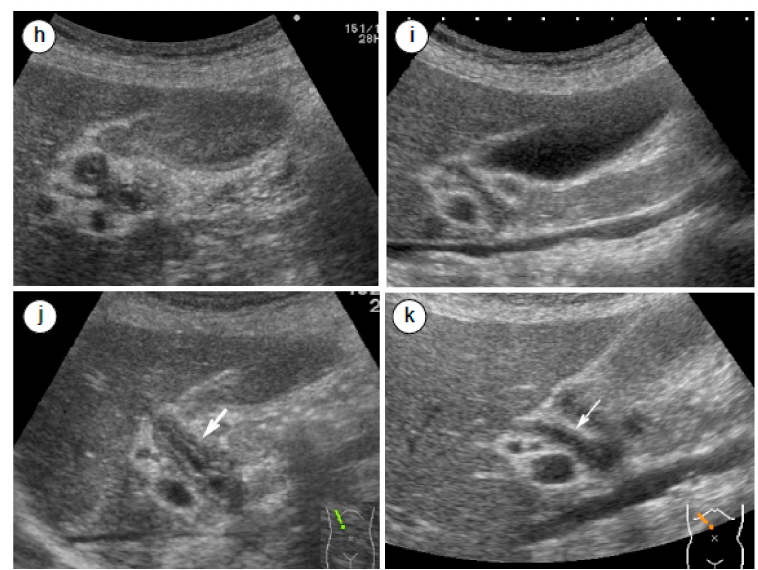
Figure 2. A case of Mikulicz disease with autoimmune pancreatitis (AIP) accompanied by multiple immunoglobulin G4 (IgG4)-related systemic lesions in a 70 year-old female patient. ( a ) Visualization by 18F-fluorodeoxyglucose-positron emission tomography (FDG-PET) of systemic inflammatory lesions with abnormal FDG uptake (the arrow heads indicate from the top to the bottom: dacryoadenitis, sialadenitis, mediastinum lymphadenopathy, hepatic pseudotumor, autoimmune pancreatitis, and choledocho-chlecystitis. ( b ) Disappearance of the lesions 3 months after steroid initiation. ( c ) Computed tomography before steroid treatment demonstrated an enlarged pancreas with a capsule-like rim (thin arrow) and markedly thickened hilar bile duct (thick arrow). ( d ) Computed tomography 1 year after steroid initiation revealed pancreatic parenchymal shrinkage and improved bile duct thickness. ( e ) Abdominal ultrasonography before ( f , h , j ) and 2 months after ( g , i , k ) steroid therapy showed a dramatic improvement in the size of the pancreas, as well as wall thicknesses of the gallbladder up to the hilar bile duct (white arrows).